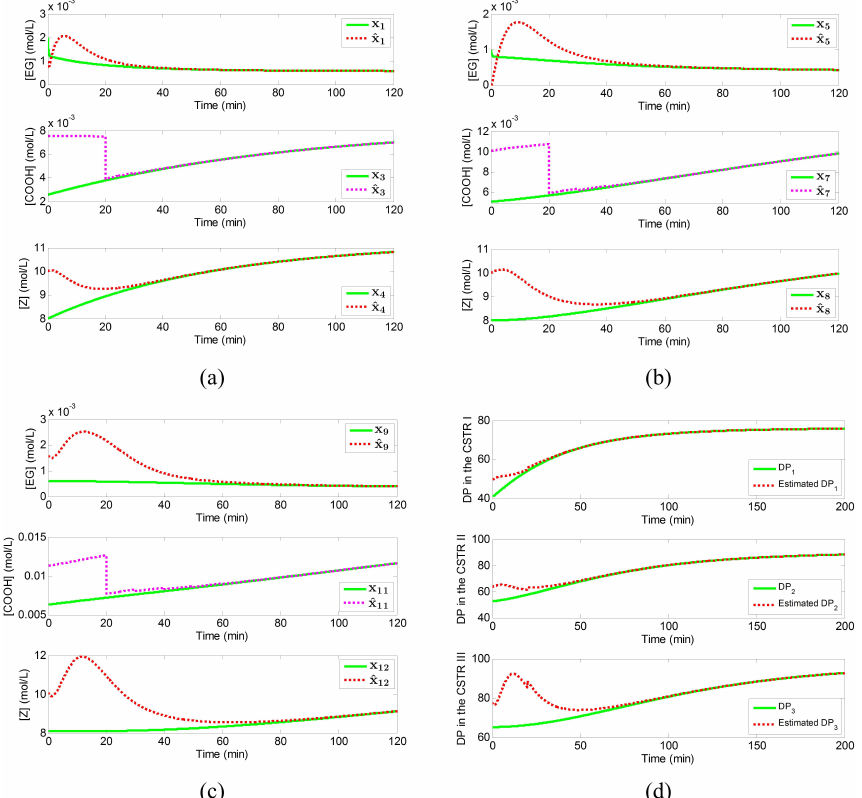
Figure 6. Performance of the reduced-order observer with “slow” eigenvalues when using both measurements: ( a ) actual and estimated states in CSTR I; ( b ) actual and estimated states in CSTR II; ( c ) actual and estimated states in CSTR III; ( d ) actual and estimated degree of polymerization in all three